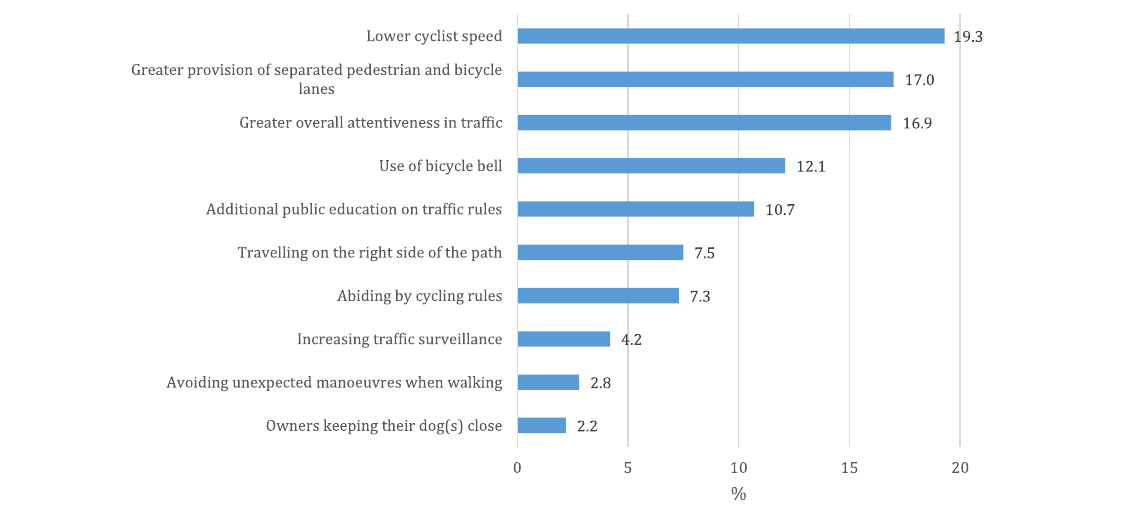
Fig. 6 Ten most frequent suggestions regarding the reduction of pedestrian-cyclist collisions and near accidents ( n =